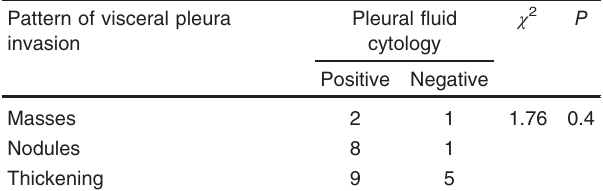
Table 5 Relation between pattern of visceral pleura invasion and pleural fluid cytology Pattern of visceral pleura